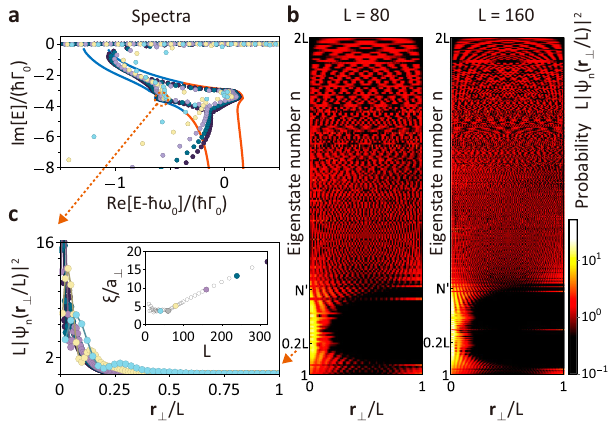
Fig. 3 | Size dependence of non-Hermitian skin effect in a ribbon geometry. a TheOBCspectraat L =40,80,160,240,and320unitcells(lightblue,lightyellow, purple, darkgreen, and black, respectively)graduallyapproach bulkspectrum as L increases. b Rescaledprobabilitydistributionsofnormalizedrighteigenstatesat80 and 160 unit cells in the ascending order of the imaginary part of eigenenergy. N 0 represents the number of localized modes in spatial distributions in Fig. 2b, c. c Rescaled probability distributions of the n =0.2 L eigenstates. The inset shows a crossover from a constant to scale-free characteristic length as system size increases,and a ⊥ isthelatticeconstantforthisribbongeometryinthe r ⊥ direction. The plots are obtained with the same parameters in Fig. 2b at k ∥ =0.1 π / a the oblique ([11] direction) but not at the horizontal ([10] direction)